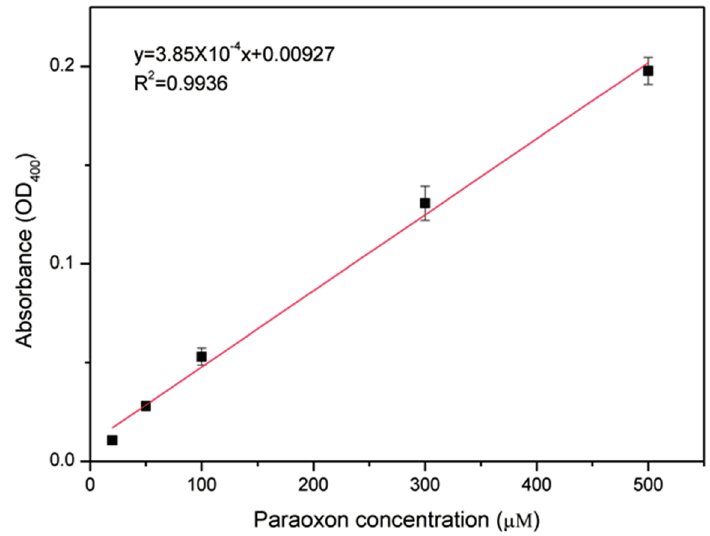
Figure 5. Detection of paraoxon using E. coli -attached SWNT film. Error bars indicate standard deviations. The absorbance increased linearly as the paraoxon concentration was